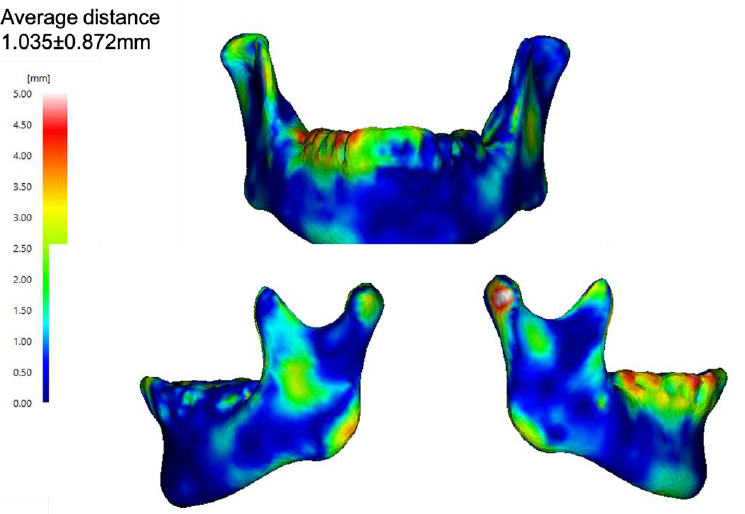
Figure 3. In face-to-face distance, the mean absolute error between the predicted mandible and the actual